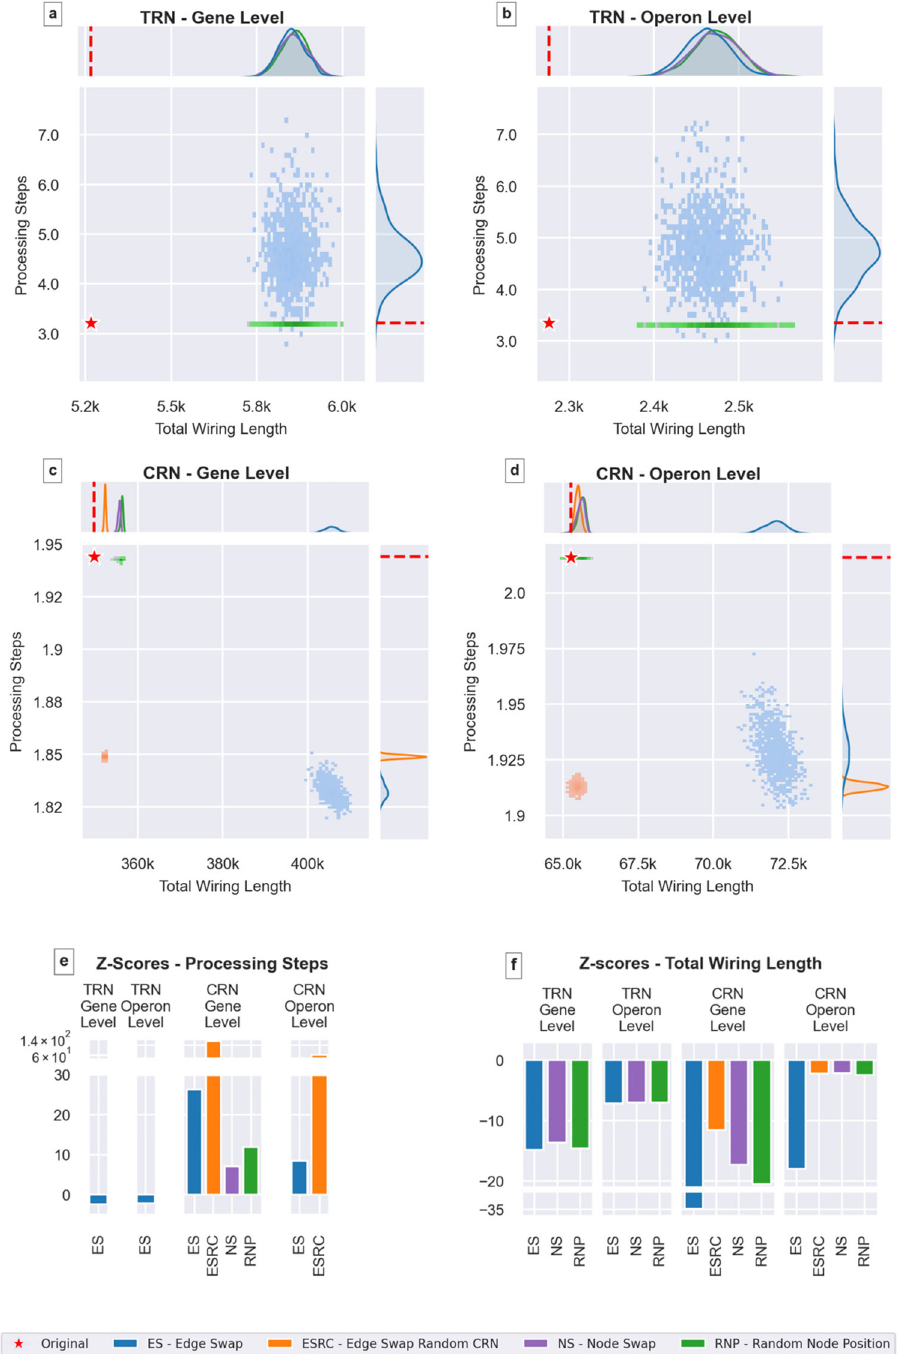
Fig. 3 Comparison of the original network ( ) and null models (dots colored according to null model type) in terms of wiring length and number of processing steps in the TRN (a,b) and the CRN (c,d) on the gene (a,c) and operon (b,d) levels. a Gene-level TRN. Original network has a signi fi cantly lower wiring length than the randomized networks with an average z-score of − 14.38. The number of processing steps is also lower in the original network, compared to its randomized counterparts (z-score = − 2.37). b Operon-level TRN. Results are consistent with the gene level (wiring length average z-score = − 7.05, processing steps z-score = − 2.20). c Gene-level CRN. The original network has signi fi cantly lower wiring length than the randomized networks with an average z-score of − 21.05. The number of processing steps is much higher than expected at random (average z-score = 42.15). d Operon-level CRN. Results are consistent with the gene level (wiring length average z-score = − 6.21, processing steps average z-score = 17.44). e Processing step z-scores. f Wiring length one-dimensional sliding of TFs along the DNA. The results are It is conceivable that setting constraints in numerically consistent with the observation in Fig. 3, showing that regardless generating networks to prevent self-regulation may create a bias of the TF ’ s target ’ search method ’ , the network displays high towards higher wiring length at randomized networks (the wiring economy (Supplementary Figure 2). elimination of interactions that originate and end at the same